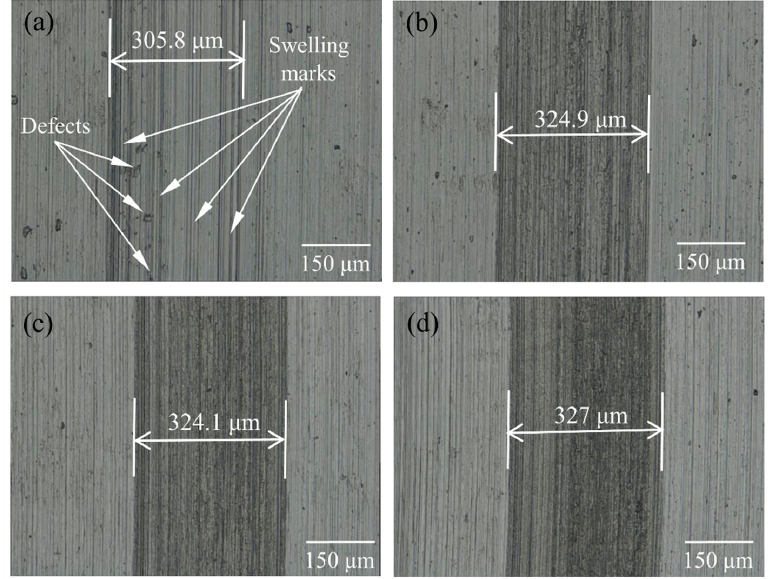
Figure 5. Micrographs of machined micro-groove (the predetermined depth of cut was 8 μ m): ( a ) processed by CC, ( b ) processed by UEVC (TSR = 1/12), ( c ) processed by UEVC (TSR = 1/24) and ( d ) ( a ) processed by CC, ( b ) processed by UEVC (TSR = 1 / 12), ( c ) processed by UEVC (TSR = 1 / 24) and processed by UEVC (TSR = 1/48). ( d ) processed by UEVC (TSR = 1 /